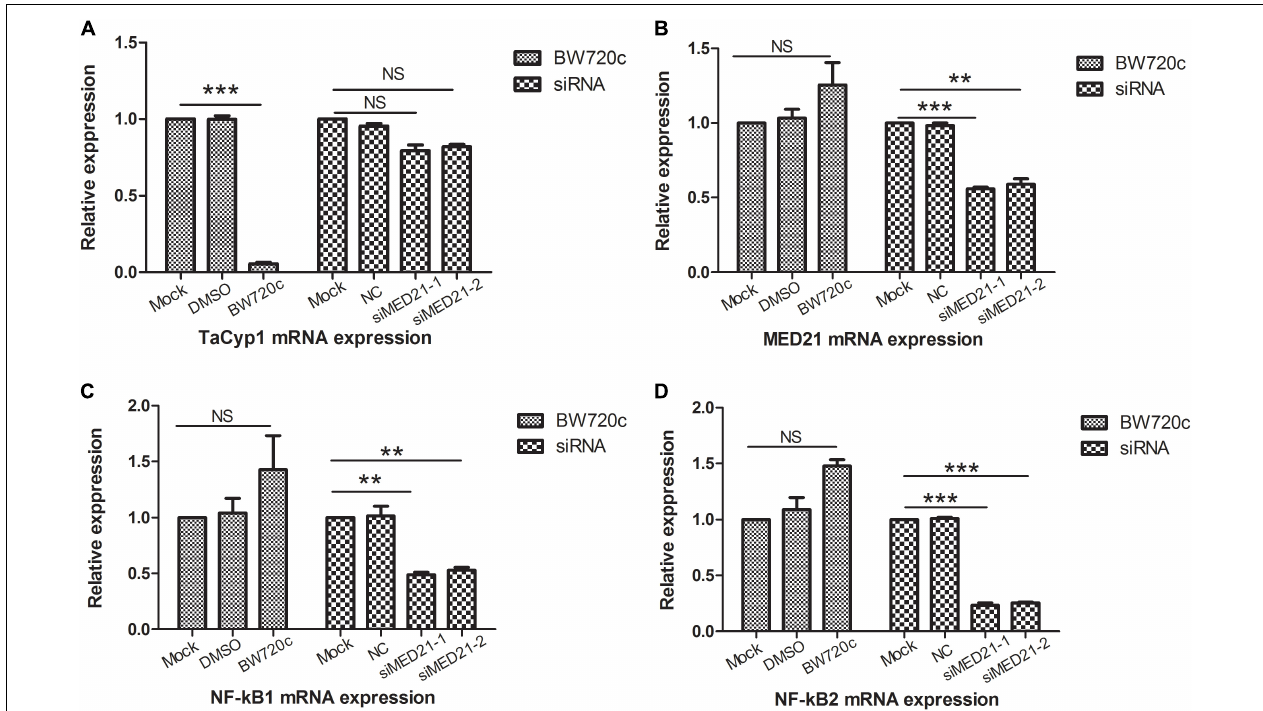
FIGURE 5 | mRNA expression analysis of TaCyp1, MED21, NF- κ B1, and NF- κ B2. mRNA expressions of TaCyp1, MED21, NF- κ B1, and NF- κ B2 in TaNM1 cells were detected after BW720c treatment and MED21 RNAi experiments (A–D) . In BW720c treatment experiment, mock group was added with PBS, NC group was added with DMSO; positive group was added with equal volume of BW720c; in MED21 RNAi experiment, mock group was with no RNA transfection, NC group was transfected with NC siRNA, positive group was transfected with siRNA. ∗∗ P < 0.01; ∗∗∗ P < 0.001. NS, not significant.